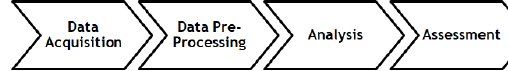
Figure 2. General workflow